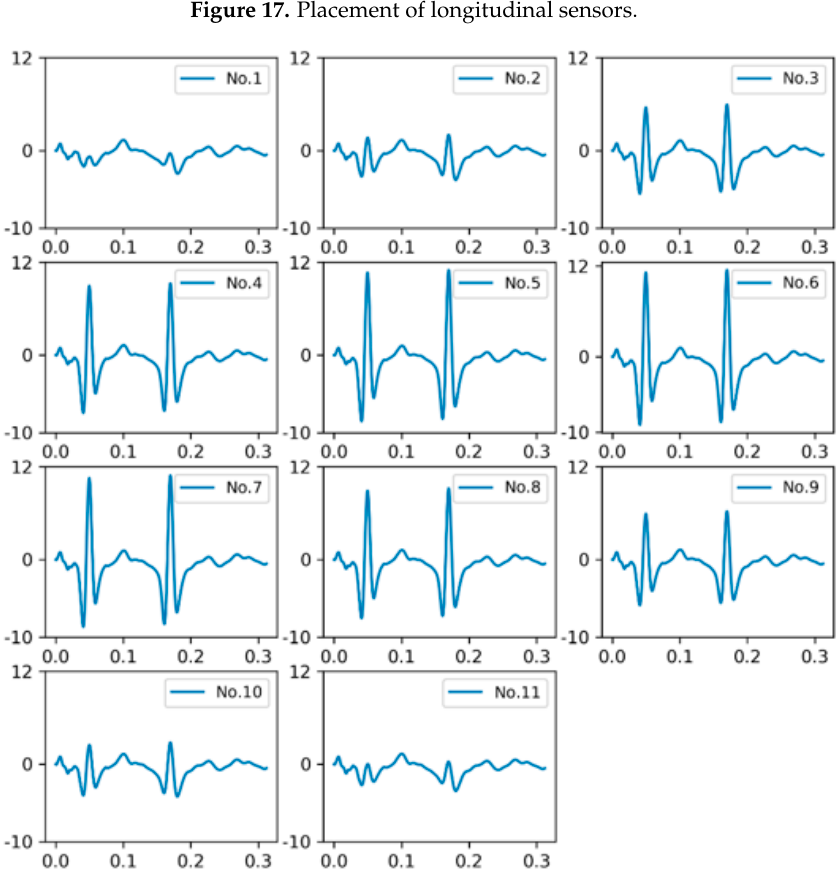
Figure 18. Outputs of longitudinal sensors.